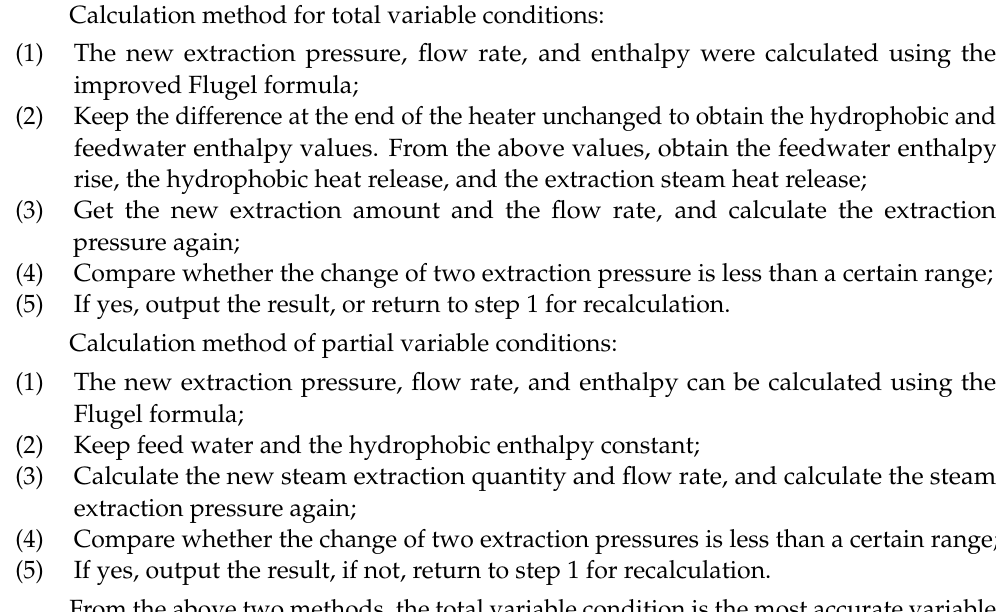
Instead of the i